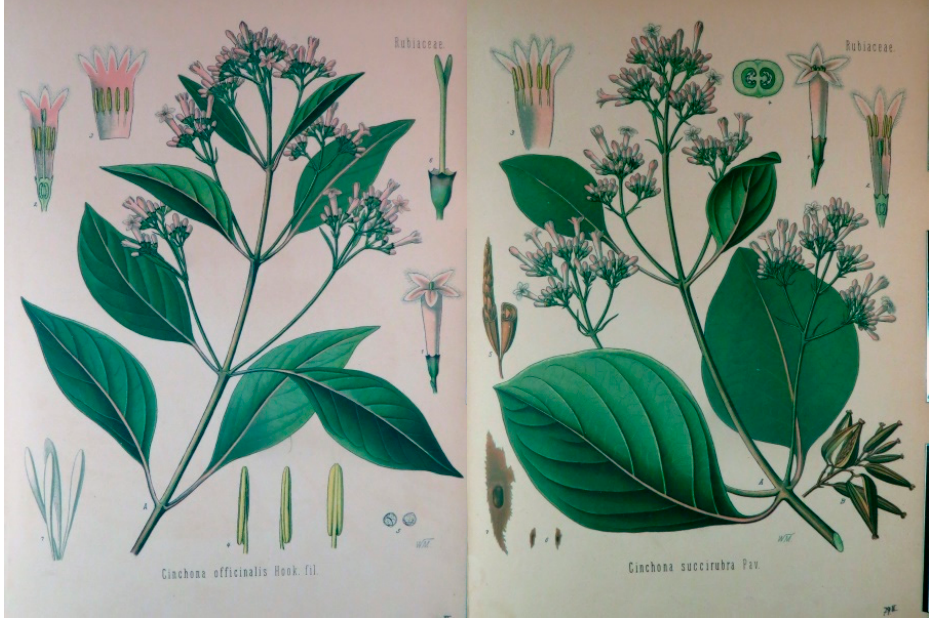
Figure 4. Cinchona officinalis L. and C. pubescens Vahl. [38].